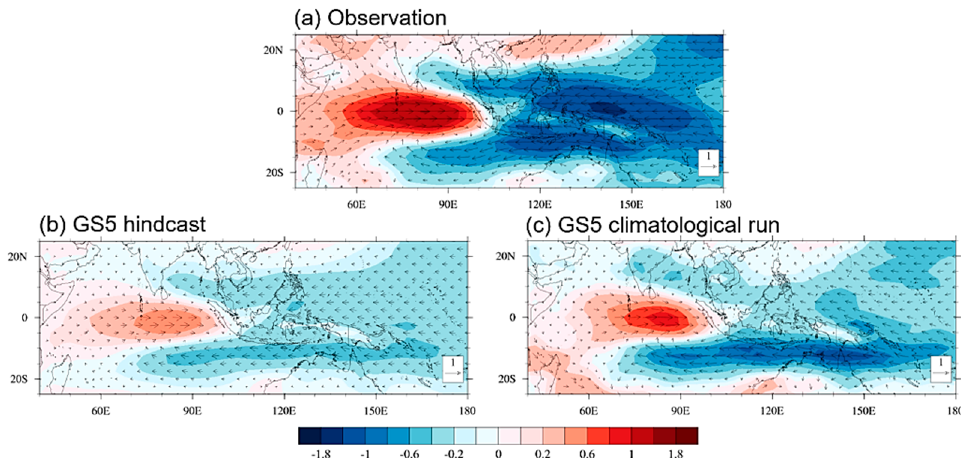
Figure 9. The regressed 20–70-day filtered 850 hPa winds (m s − 1 ; vector) and zonal wind speed (m s − 1 ; shading) onto filtered precipitation (20–70 days) averaged over the eastern Indian Ocean (10° S–10° N, 80°–100° E) from ( a ) observation, ( b ) GS5 hindcast data, and ( c ) GS5 climatological run. The strengths of regression are fixed to a 3 mm day − 1 .